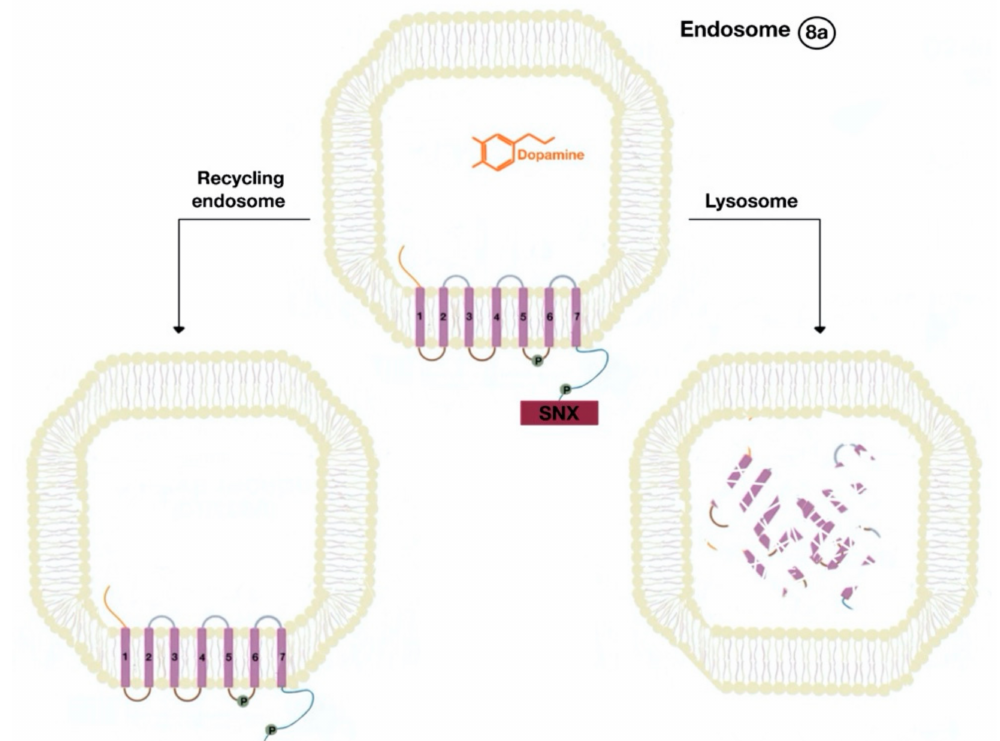
Figure 8. The endocytosed GPCR (dopamine receptor) binds to sorting nexin (SNX) that sends the GPCR either to a recycling endosome or lysosome (8a). Receptors targeted to lysosomes are degraded. The SNXs are a diverse group of membrane-linked phosphoinositide-binding proteins that regulate cellular protein tra ffi cking by controlling all aspects of the endocytic pathway, including endocytosis, endosomal sorting, and endosomal signaling [16]. The SNX either sorts the endocytosed and dephosphorylated / resensitized GPCR into the fast recycling endosomes, targeting it to lipid rafts (Figure 9), or send such receptor to late endosomes, targeting it to lysosomes, inducing the inevitable degradation of the GPCR